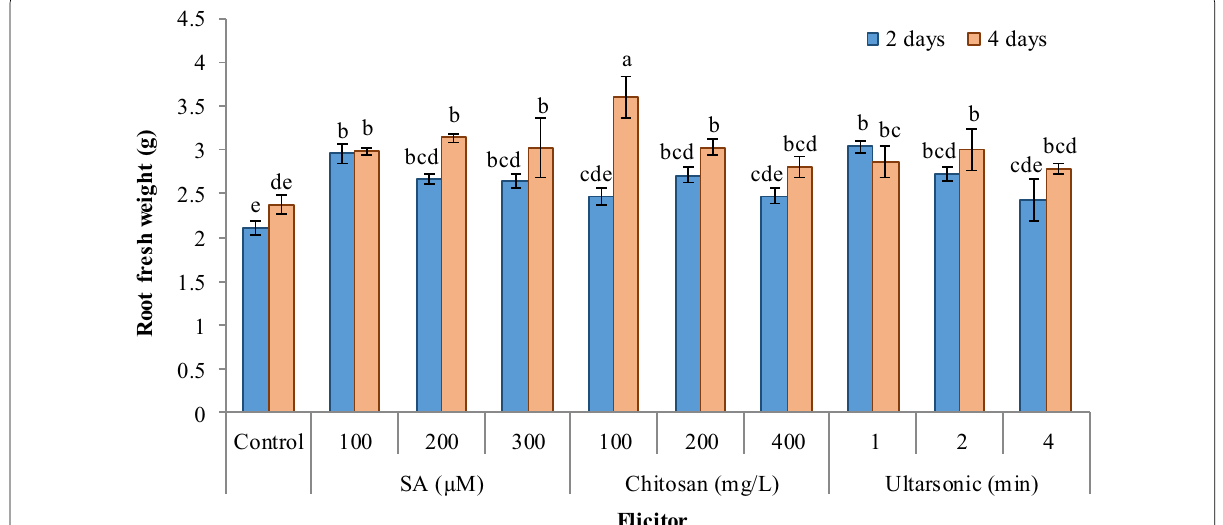
Fig. 5 Effect of different elicitors on fresh weight in hairy root culture of G. officinalis . Different letters show significant differences ( p < 0.01) among